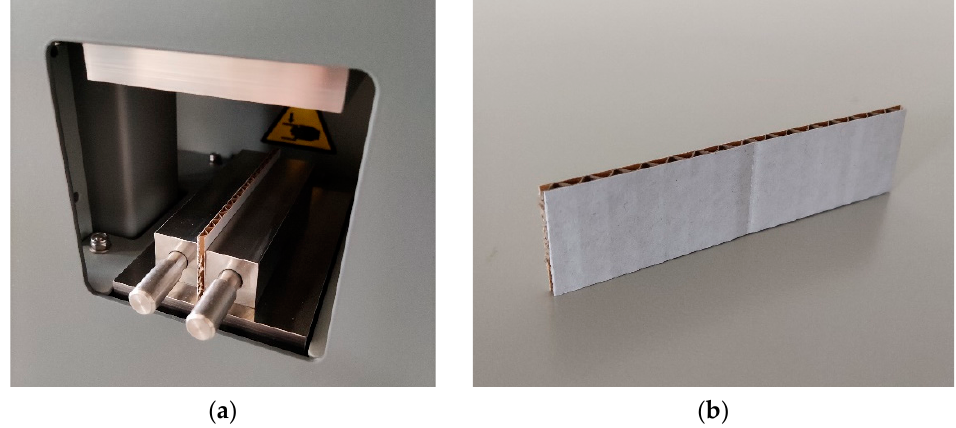
Figure 1. Edge crush test: ( a ) the testing socket and ( b ) the corrugated board sample.